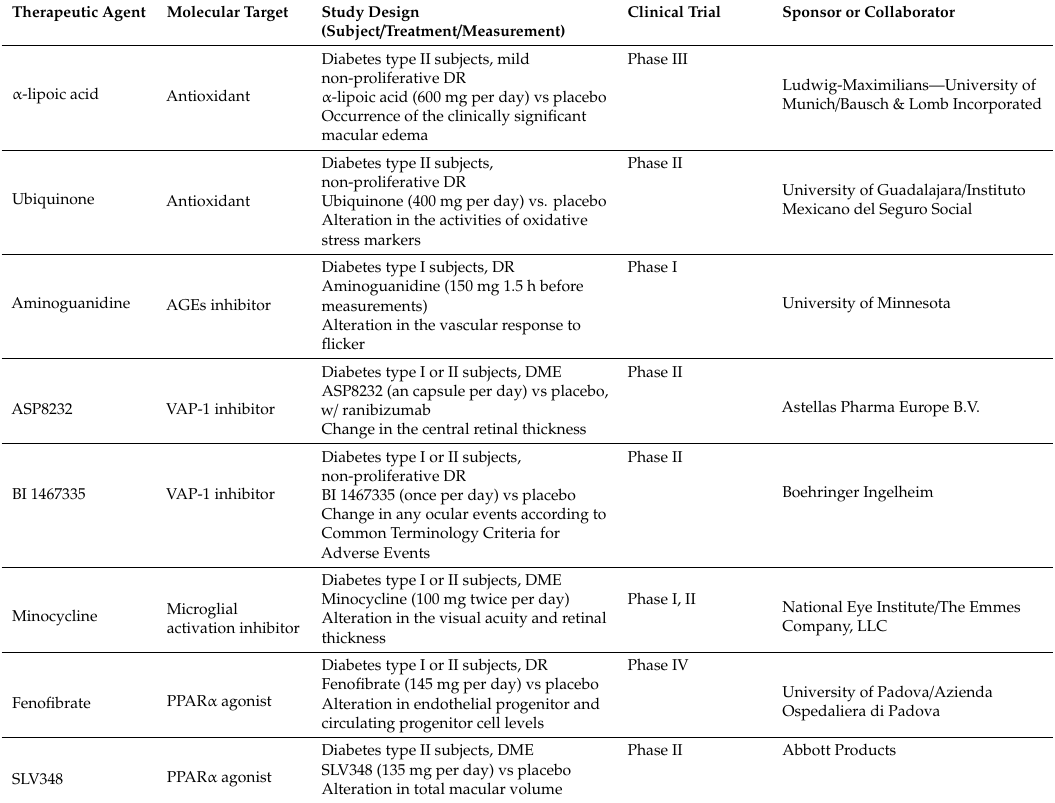
Table 1. Recently investigated oral pharmacotherapies for DR or